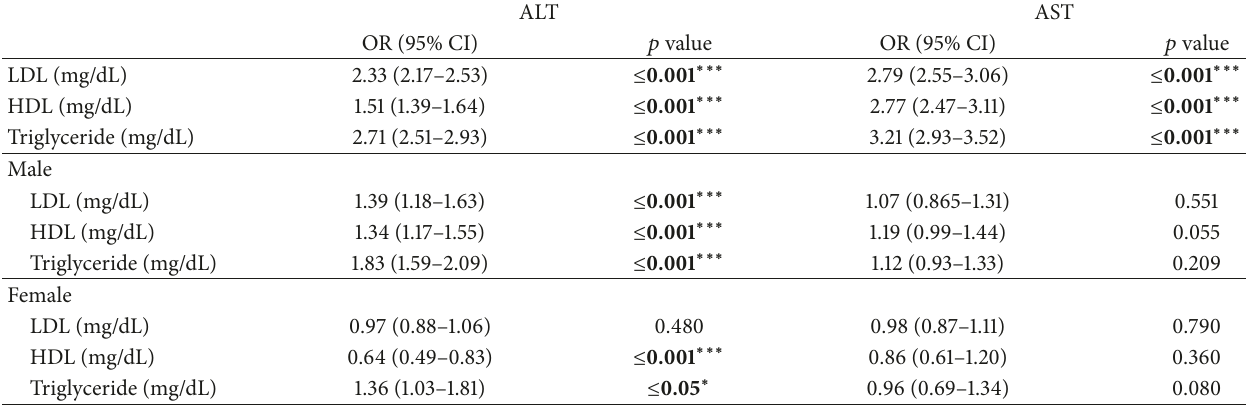
Table 5: Odds of elevated liver enzymes with lipid biomarkers.